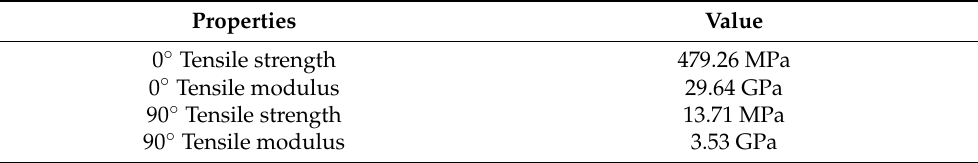
Table 2. Mechanical properties of GF/PP